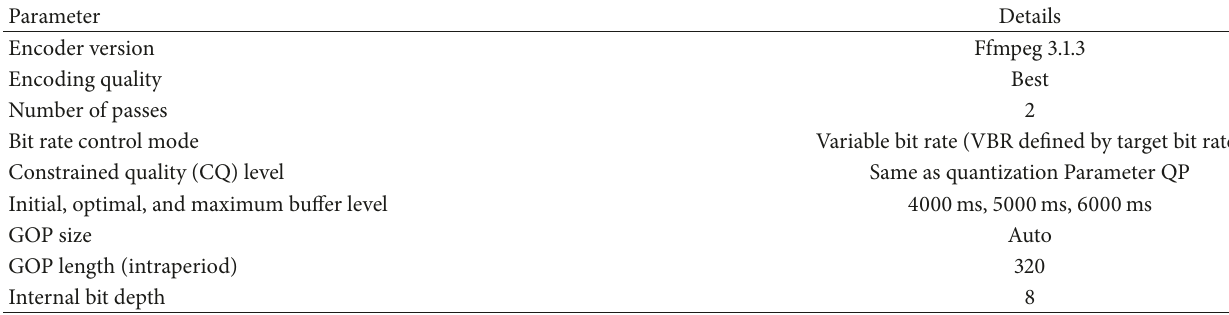
Table 3: Encoder configuration for VP9 codec.